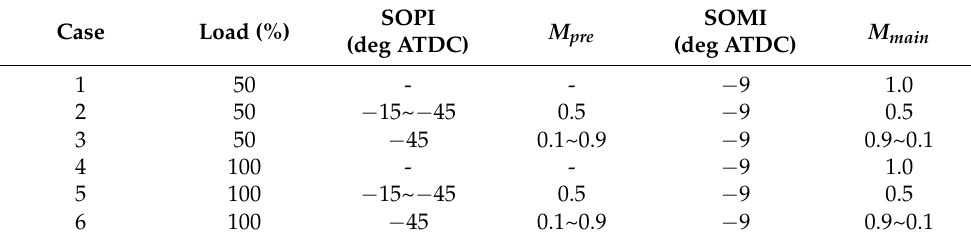
Table 5. Parameters of the pre-injection strategy.